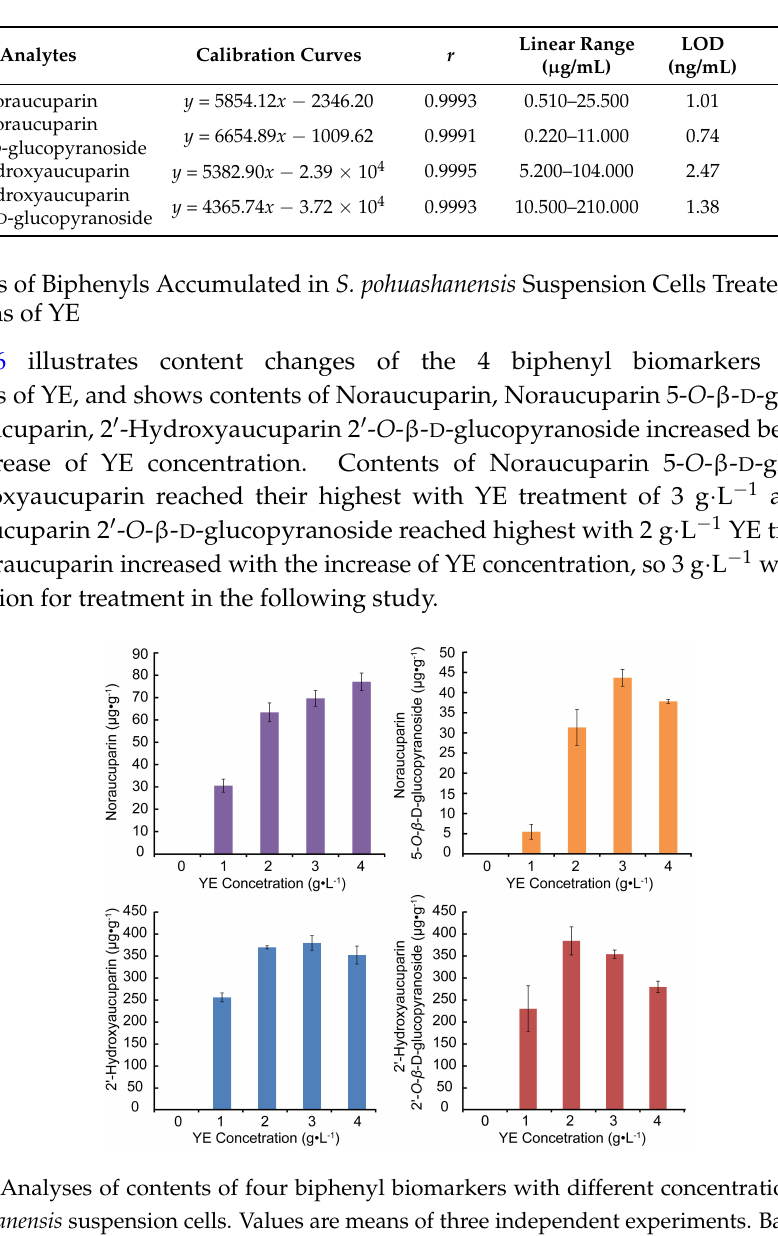
Table 2. Regression equation, correlation coefficients, linearity ranges, and limits of detection (LOD) and quantitation (LOQ) of the biphenyl compounds.